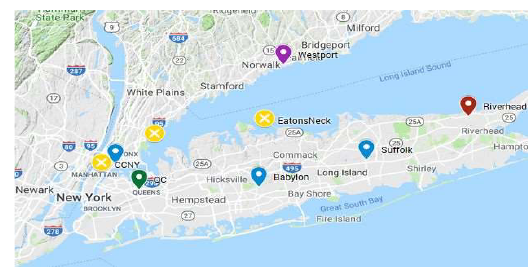
Fig.1 Ground-site location (yellow ‘x’ set by CCNY)